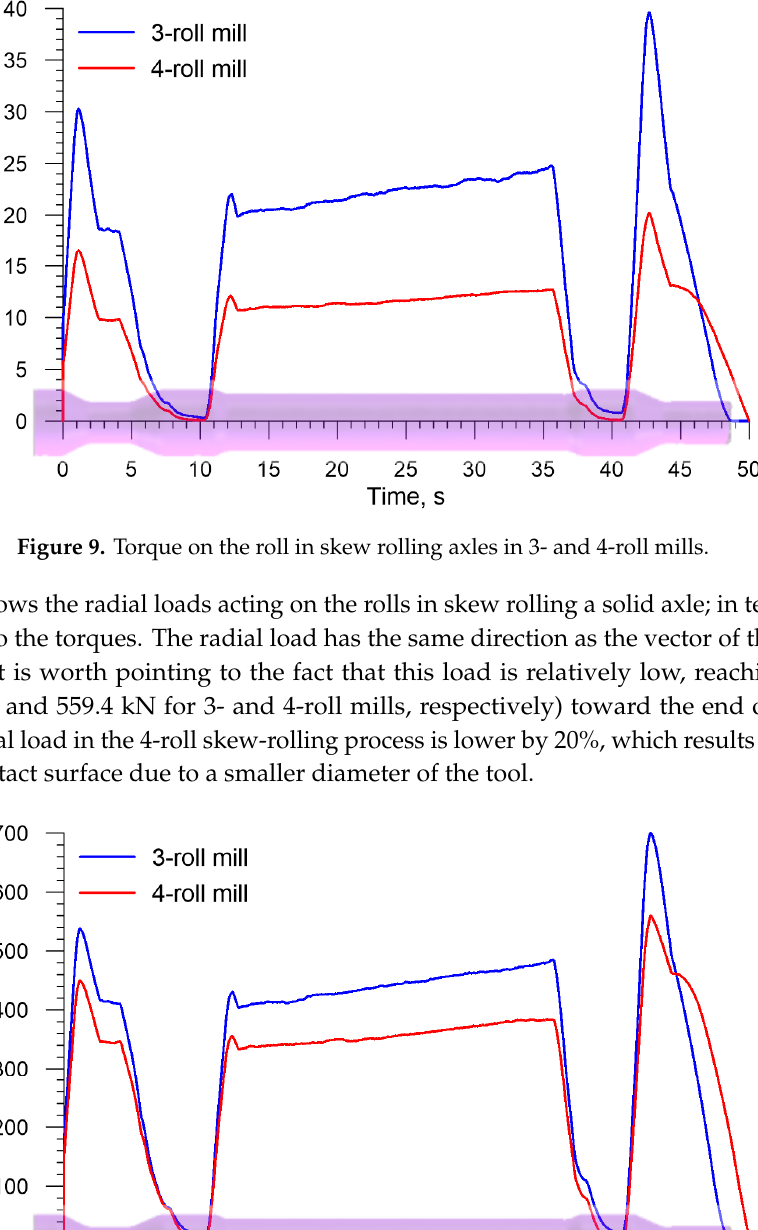
Figure 10. Radial load on the roll in skew rolling railway axles in 3- and 4-roll mills.